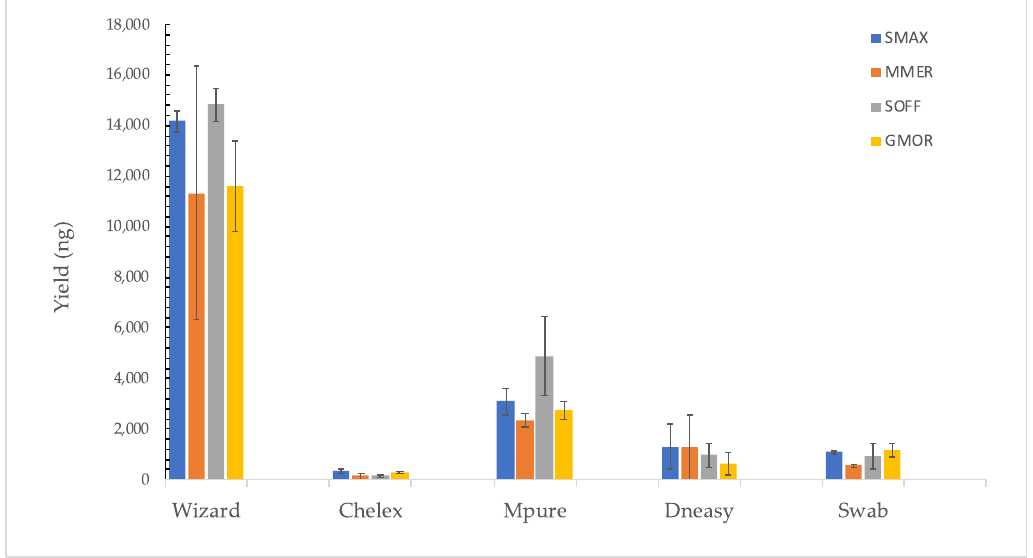
Figure 1. ( a ) Yield (ng) of the tested DNA extraction methods. Data are presented as mean ± SD of samples per method. Non-identical subscript letters (A, B, C, D) indicate a statistically significant difference ( p < 0.05). ( b ) Method efficiency (ng DNA/mg wet tissue) of the tested DNA extraction methods. Data are presented as mean ± SD of samples per method. Non-identical subscript letters (A, B, C, D) indicate a statistically significant difference ( p < 0.05).